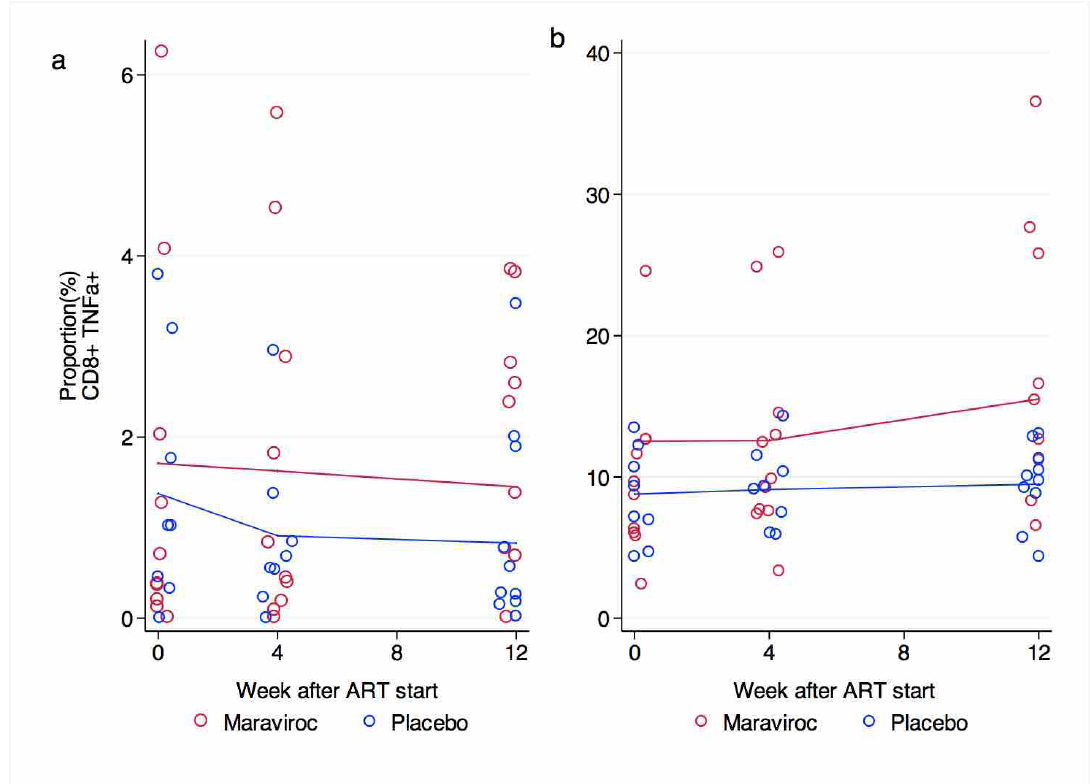
Supplementary Figure 5. Proportion of CD8 lymphocytes expressing TNFa upon exposure to CMV peptides and